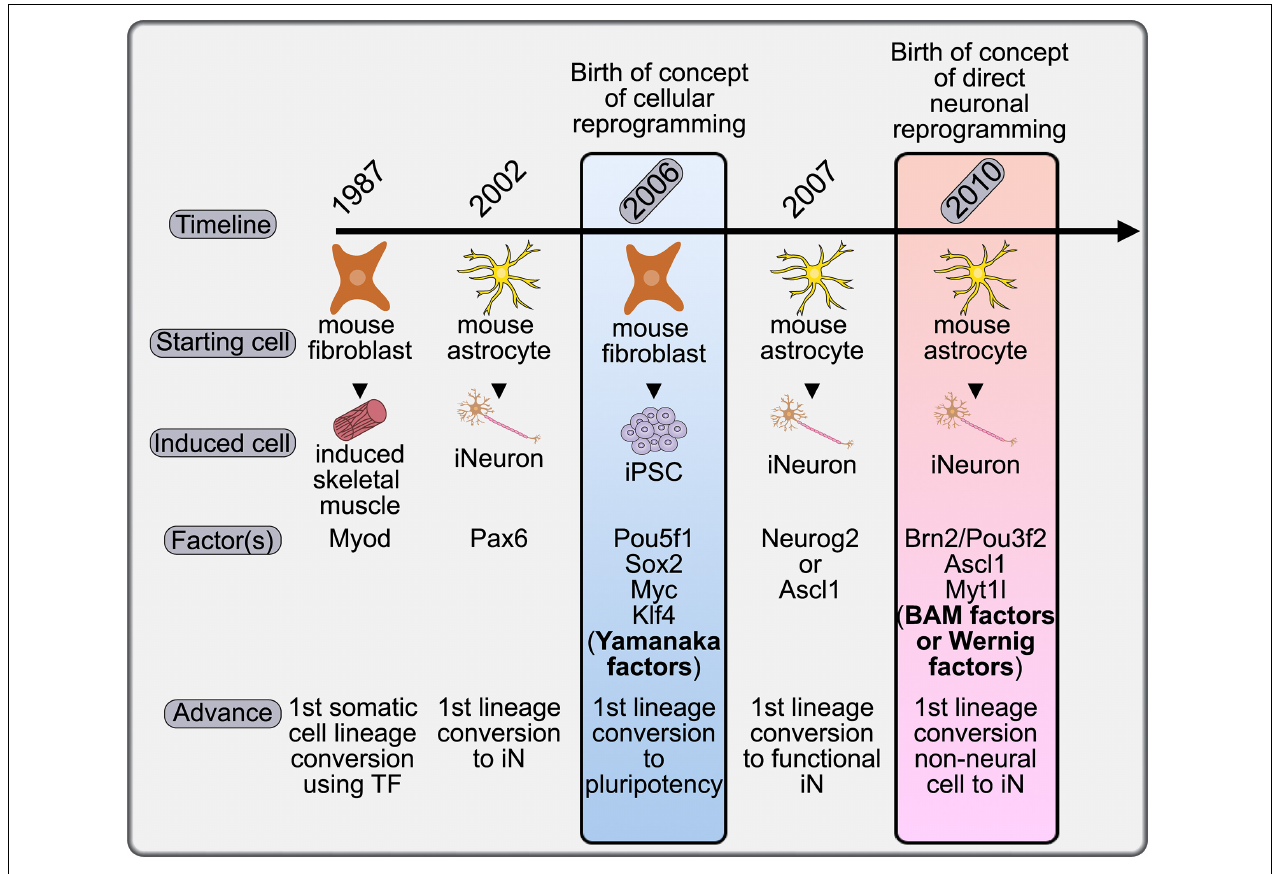
FIGURE 1 | Timeline placing the concept of direct neuronal reprogramming in a historical context. The first evidence for somatic cell conversion was achieved in 1987 with the conversion of mouse fibroblasts to skeletal muscle cells. This procedure was adapted to the generation of iNeurons in 2002 and 2007 using astrocytes as a starting population, although not yet termed direct neuronal reprogramming. It was in 2006 that the field of cellular reprogramming was born with the demonstration that the Yamanaka factors could generate iPSCs. The formal launch of the direct neuronal reprogramming field came in 2010 with the identification of the BAM factors, which could convert fibroblasts, a non-neural cell type, to iNs without passing through a transient iPSC state.